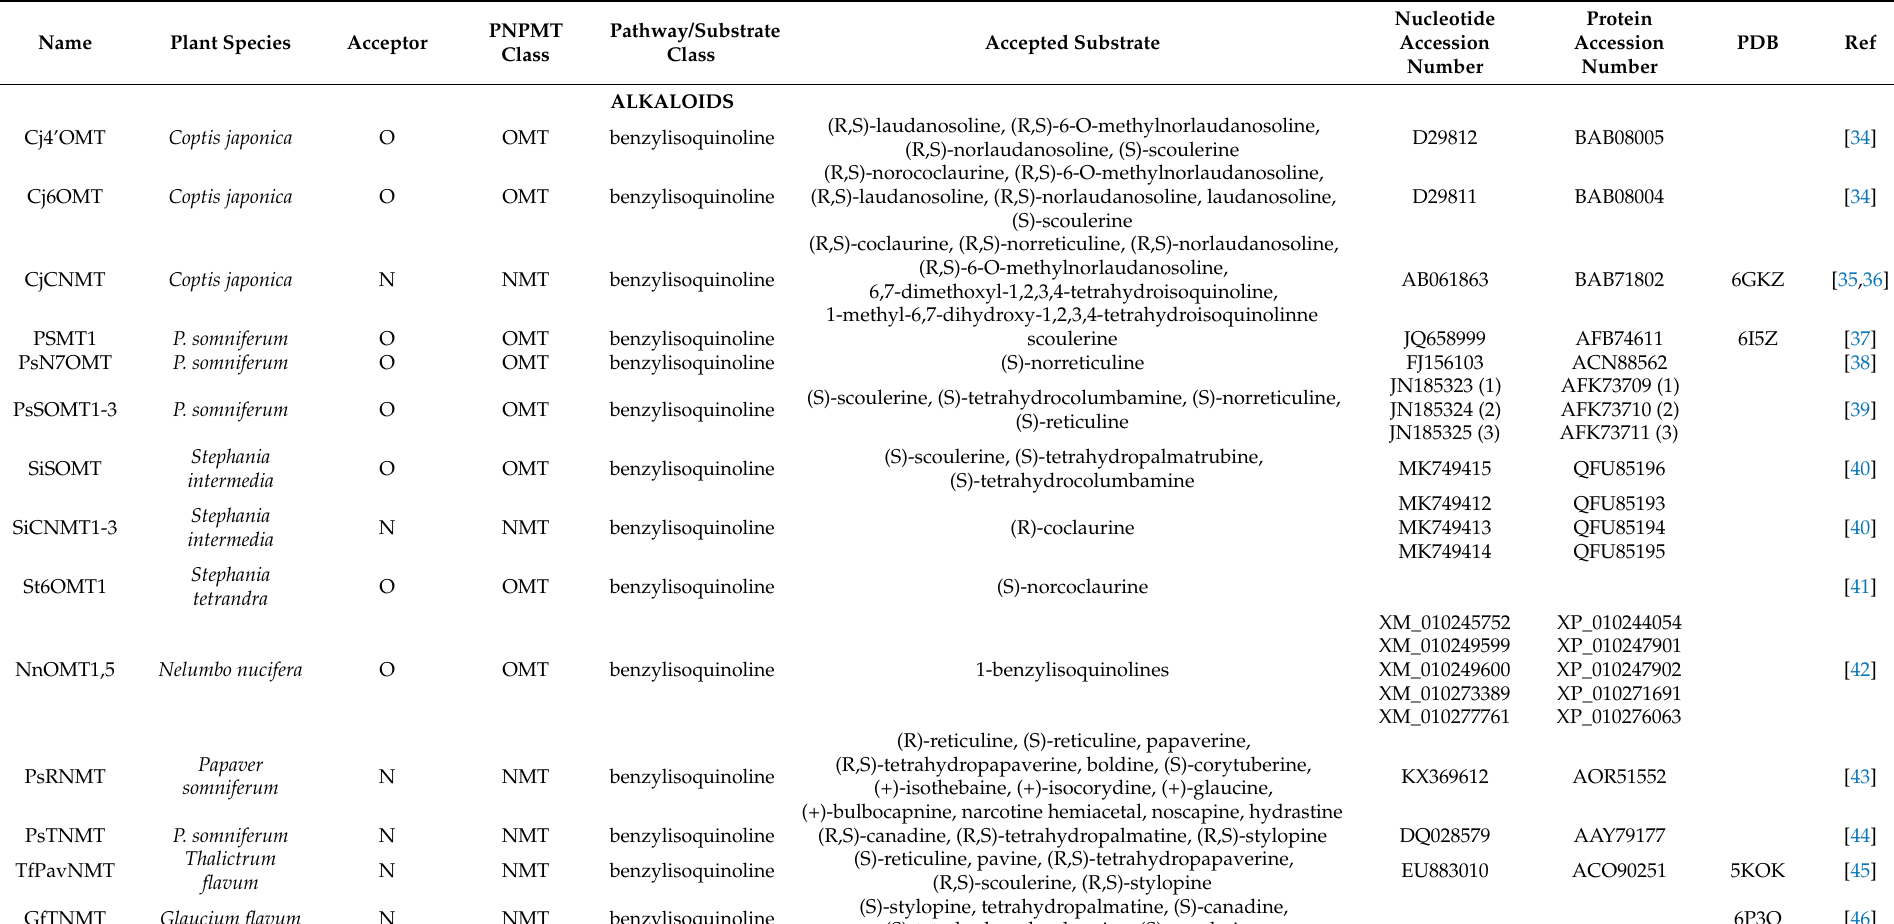
Table 1. Biochemically characterized plant natural product